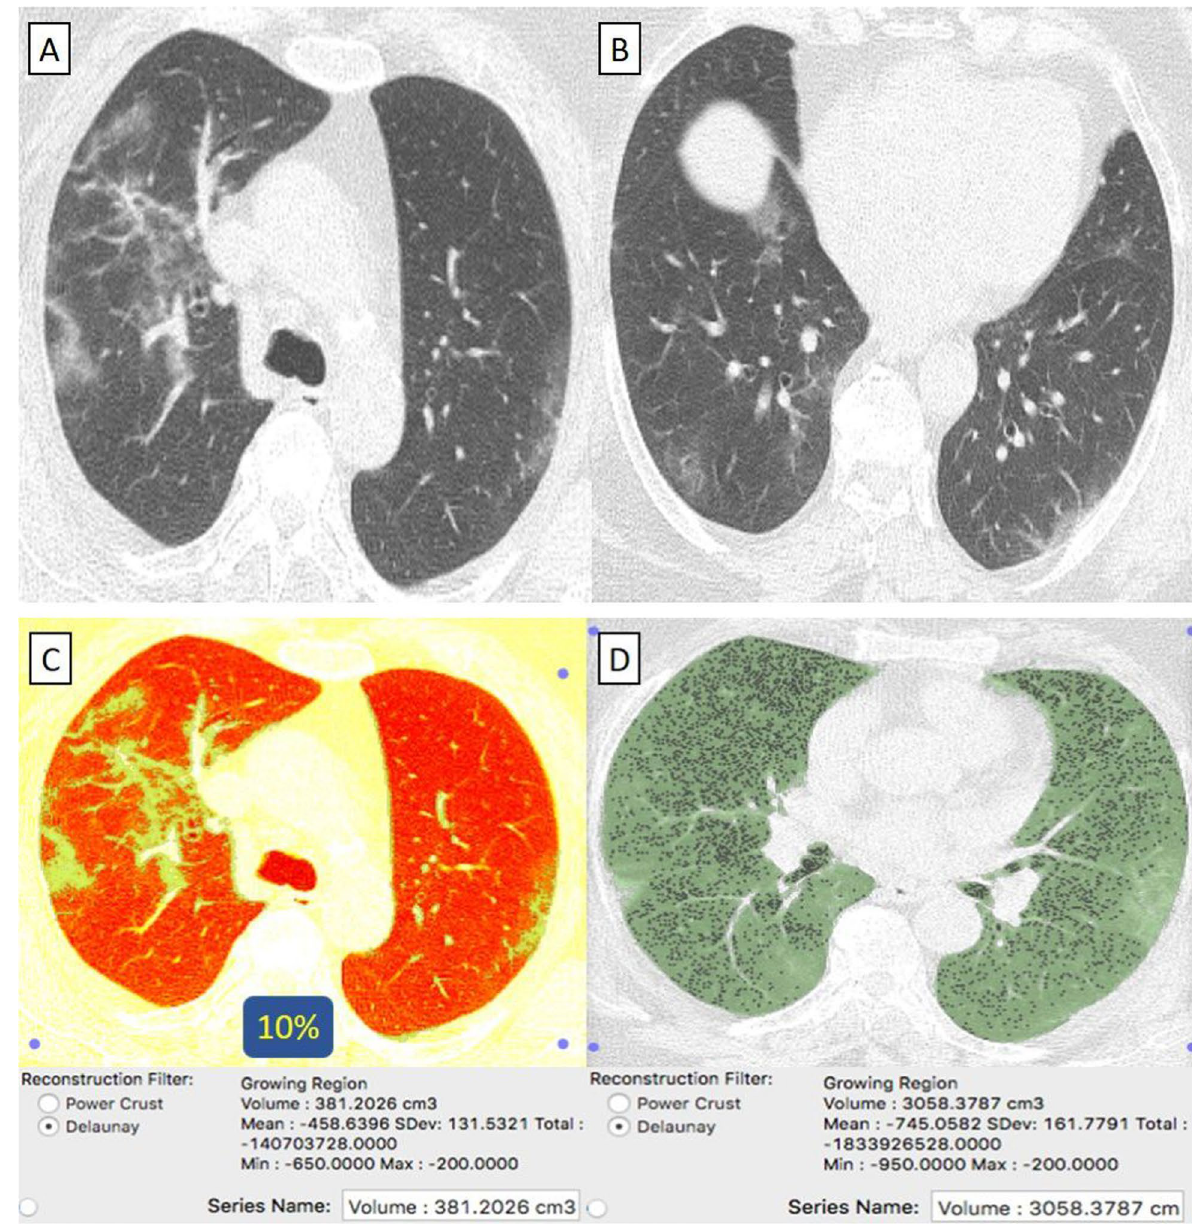
Fig. 5 A 58‑year‑old female patient with negative past medical history and had received “Phizer‑Biontech” vaccine then got COVID‑19 infection. A , B Axial chest CT cuts (lung window) showed bilateral mainly peripheral located ground‑glass pneumonic patches. C CT‑Volumetry of the pathological lung parts averages 381 cc. D CT‑Volumetry of total lung volume averages 3058 cc. So, only 10% of the lung parenchyma was diseased (Score